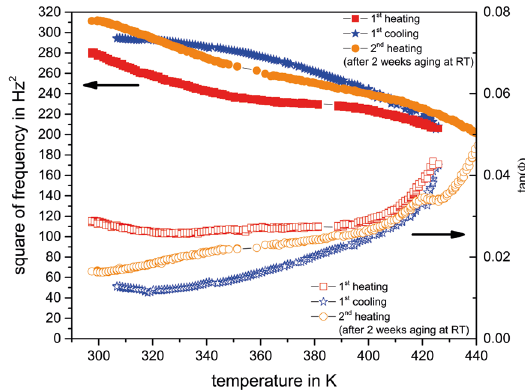
Figure 3. Measurement of the loss factor tan Φ and elastic modulus (αf 2 ) to show the effect of aging at room temperature on a sample of Arundo donax